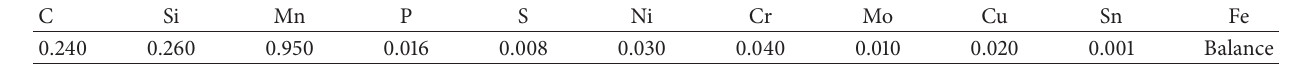
Table 2: Chemistry of steel rebar (wt.%).